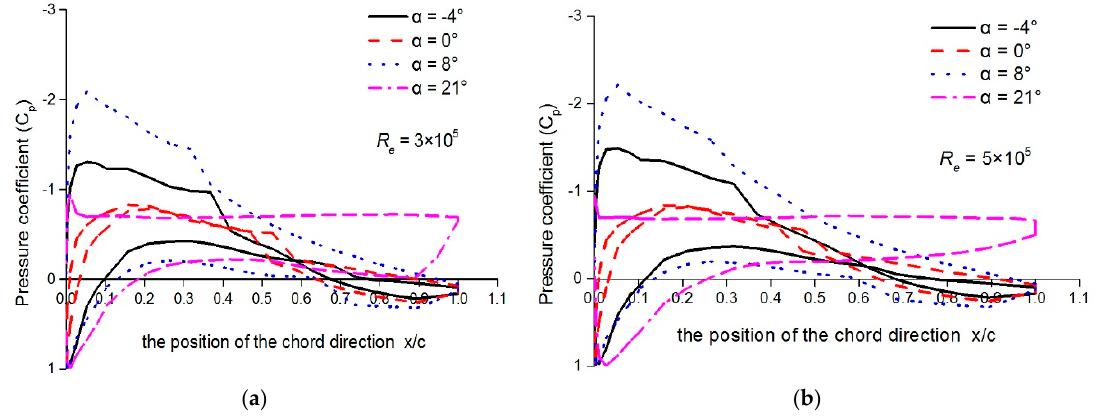
Figure 8. Pressure distribution for the LUT airfoil: ( a ) the case of R e = 3 × 10 5 ; and ( b ) the case of R e = 5 × 10 5 . The data were measured when the surface of the LUT airfoil was clean. As shown in this figure, the lines in black, red, blue, and pink show the pressure coefficients corresponding to the angles α = − 4°, α = 0°, α = 8°, and α = 21°, respectively.